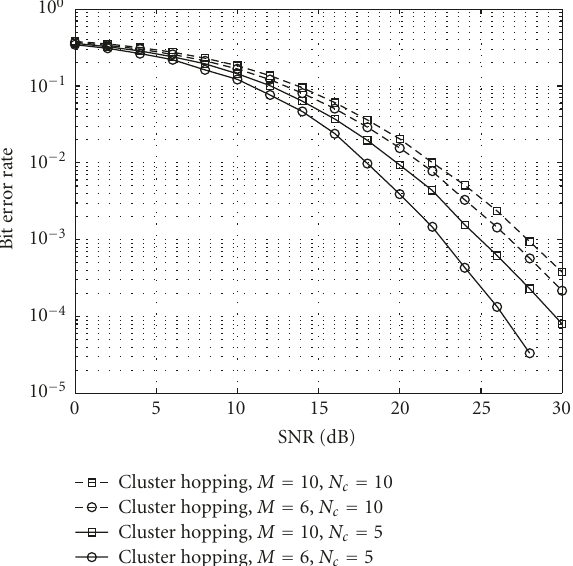
Figure 11: BER versus user loads of RNS-FH OFDMA under cluster hopping with di ff erent channel conditions, N = 110, M = M c = 10, N c = 11, SNR = 25dB, SIR = 15 dB, f D T s = 0 . 01.